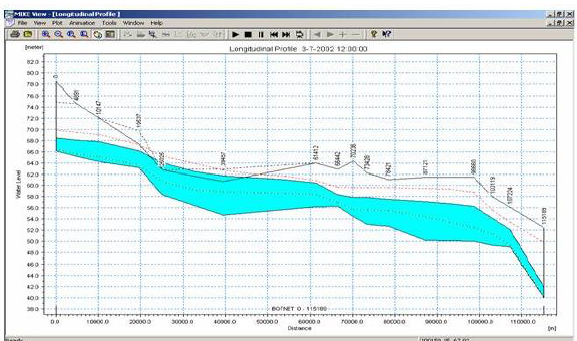
Fig. 4.3: Simulated Hydrograph at Runni Saidpur, 61.41km from Dheng Field photographs collected during field survey of October